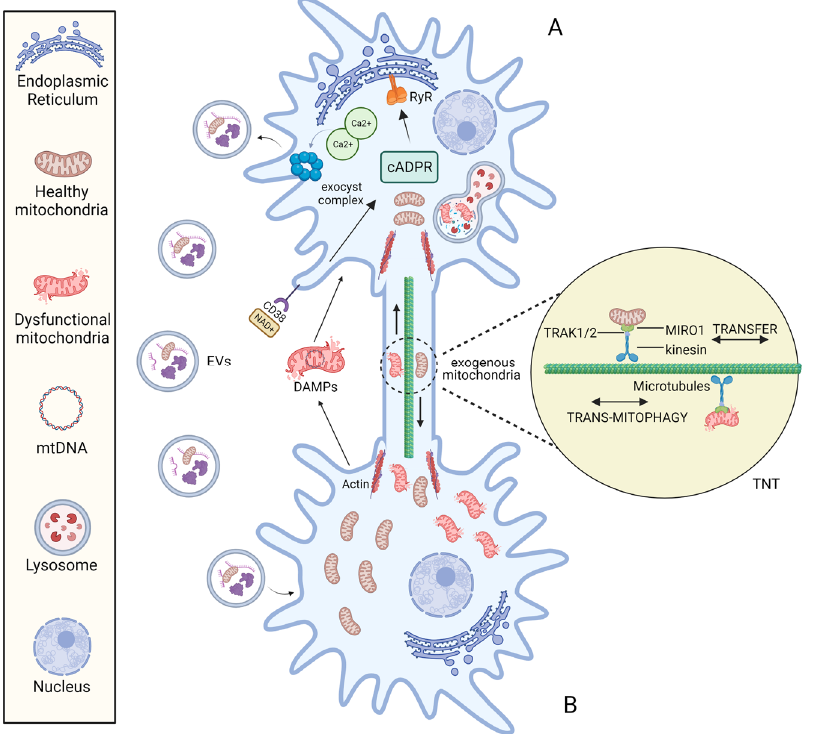
Figure 2. The mechanisms of intercellular mitochondrial transfer. Under the stimulation of stress conditions, mitochondria can be transported bidirectionally between cell A and B via the TNT structure and mitochondria-containing EVs. The formation of TNT is driven by the actin, and mitochondrial transfer between TNT-linked cells is regulated by Miro1. EV endocytosis is mediated by the NAD + /CD38/cADPR/Ca 2+ pathway: Under stress, intracellular NAD+ increases and diffuses to the extracellular environment. CD38 then catalyses NAD + to produce cADPR, a second messenger that acts on Ryanodine Receptor (RyR) on the Endoplasmic reticulum to induce the release of the intracellular Ca 2+ . Following the increase of cytoplasmic Ca 2+ mediates the activation of exocyst complex, leading to the formation and release of